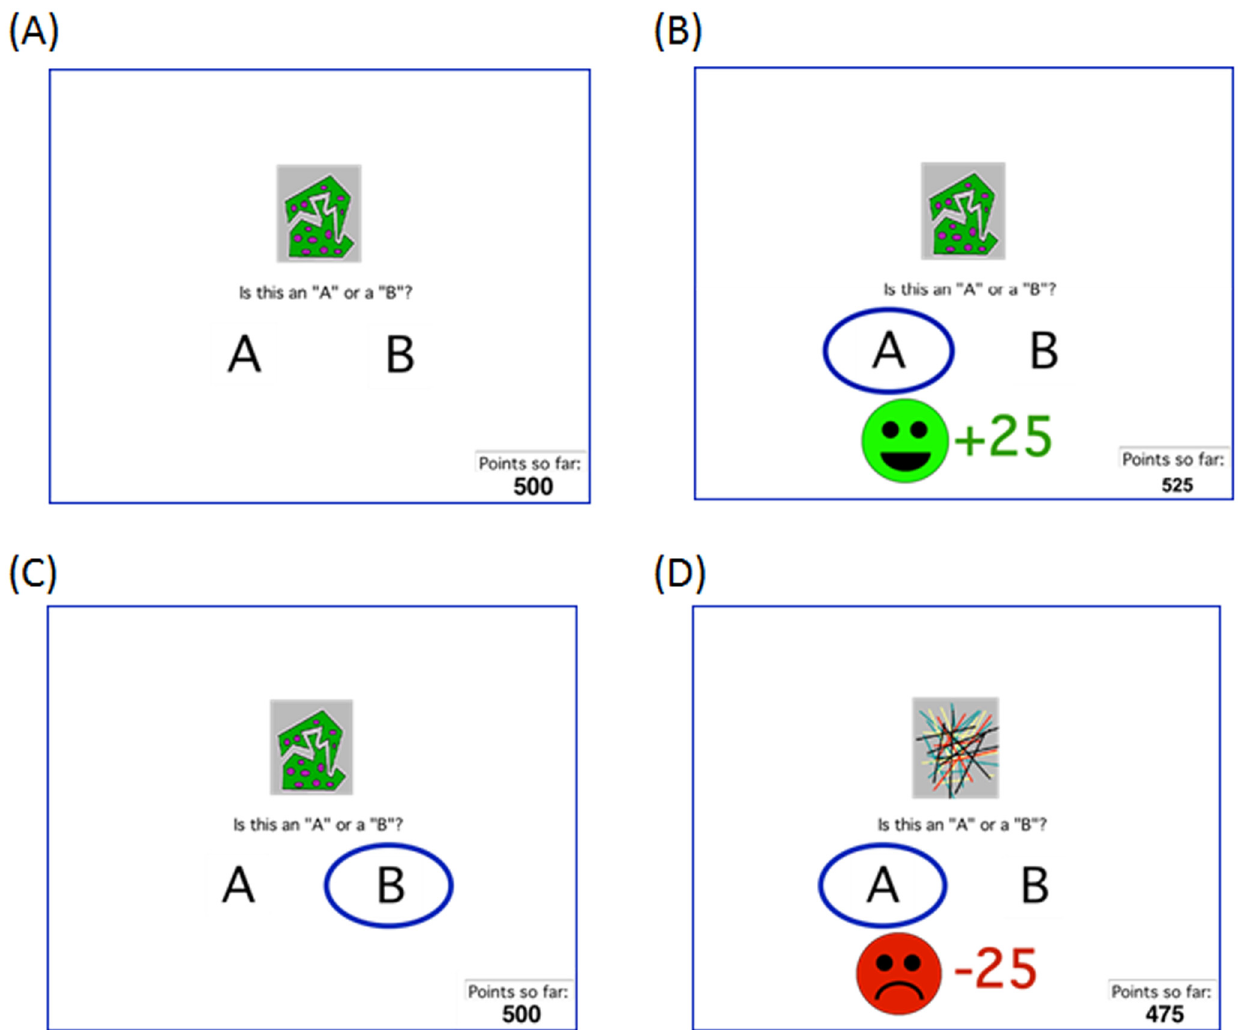
Fig 1. Example screen events. (A) On each trial, the participant sees a stimulus and is asked to classify the stimulus as belonging to category “ A ” or “ B, ” or to “ skip ” (avoid) the trial. If the subject makes a classification response, the chosen category is then circled. (B) For reward-based stimuli, correct responses are rewarded with feedback and point gain, while (C) incorrect responses receive no feedback. (D) For punishment-based stimuli, incorrect responses are punished with feedback and point loss; incorrect responses receive no feedback (similar to C). If the subject makes an avoidance response, the computer simply acknowledges the response and moves on to the next